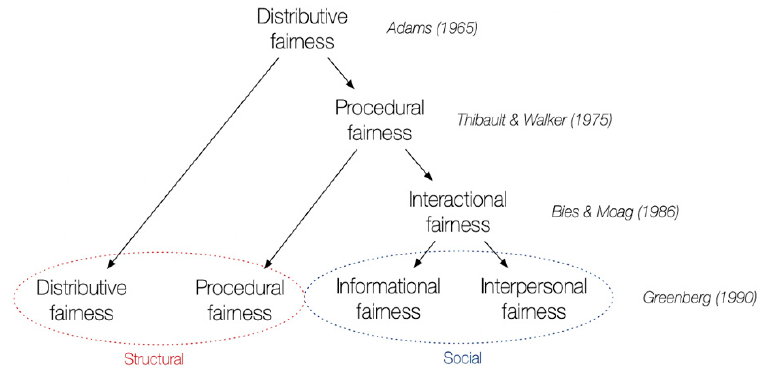
Figure 1. The development of the fairness concept.